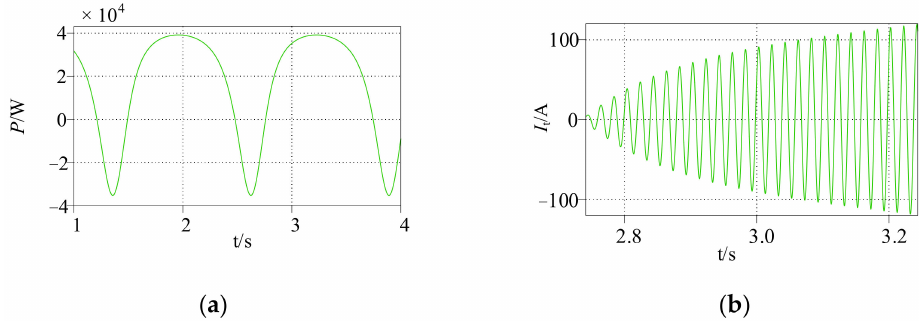
Figure 8. ( a ) Active power of a GFM converter ( P set = 50,000 W, SCR = 4.84); ( b ) current of a GFM converter ( P set = 50,000 W, SCR = 4.84).